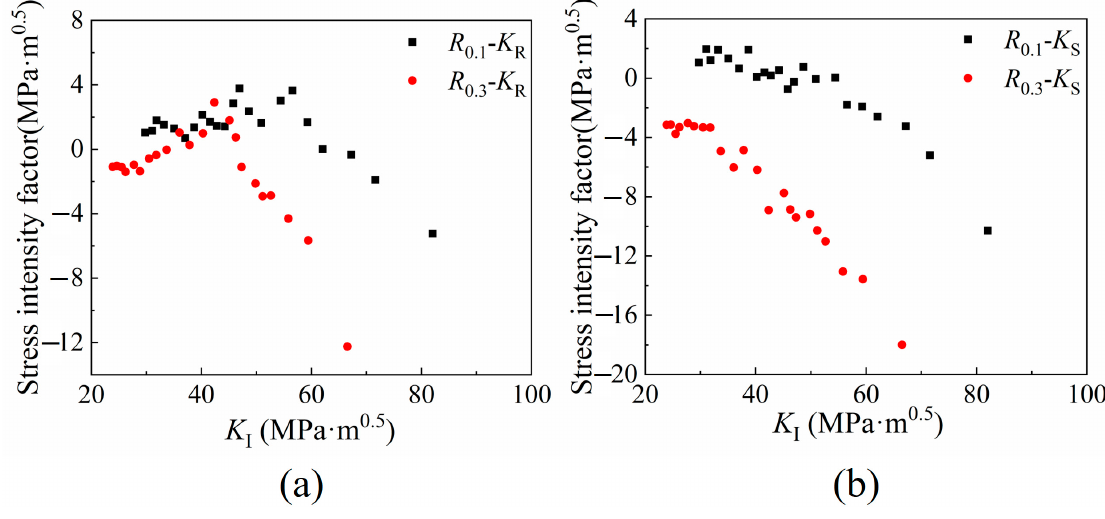
Figure 10. The variation of SIF K F with traditional SIF K I.